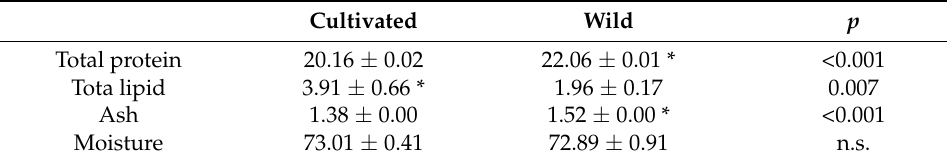
Table 2. Muscle proximate composition (% wet weight) of wild and cultivated thick-lipped grey